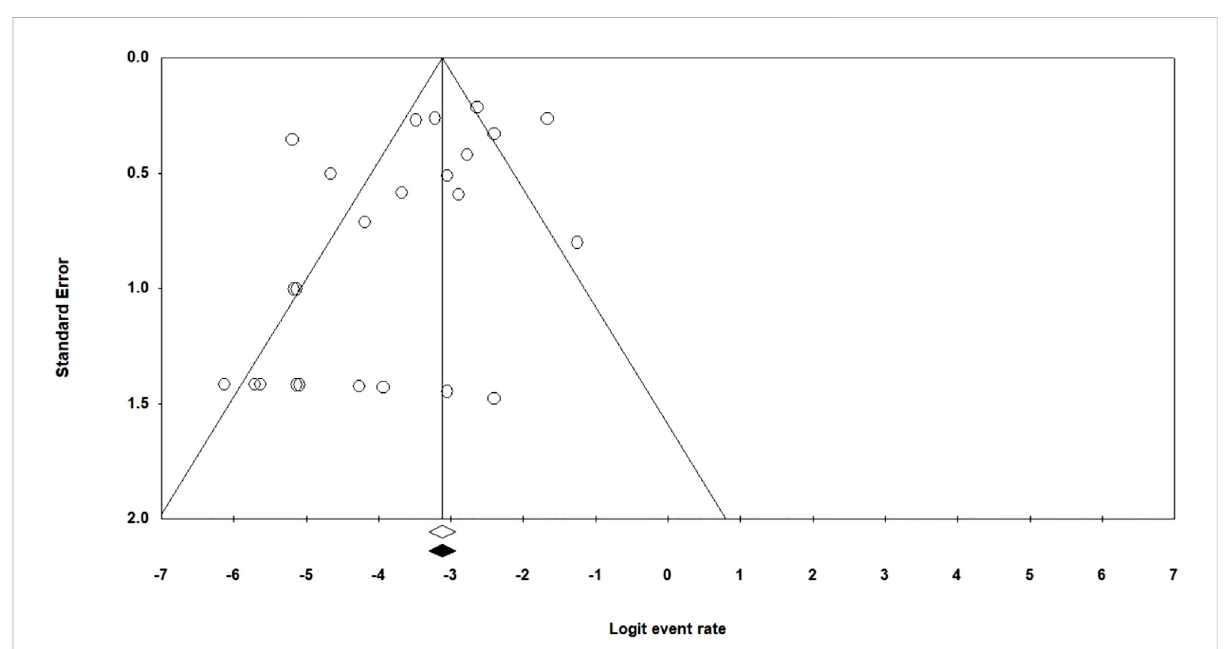
Funnel plot of the meta-analysis of Linezolid resistance in multidrug-resistant Mycobacterium tuberculosis